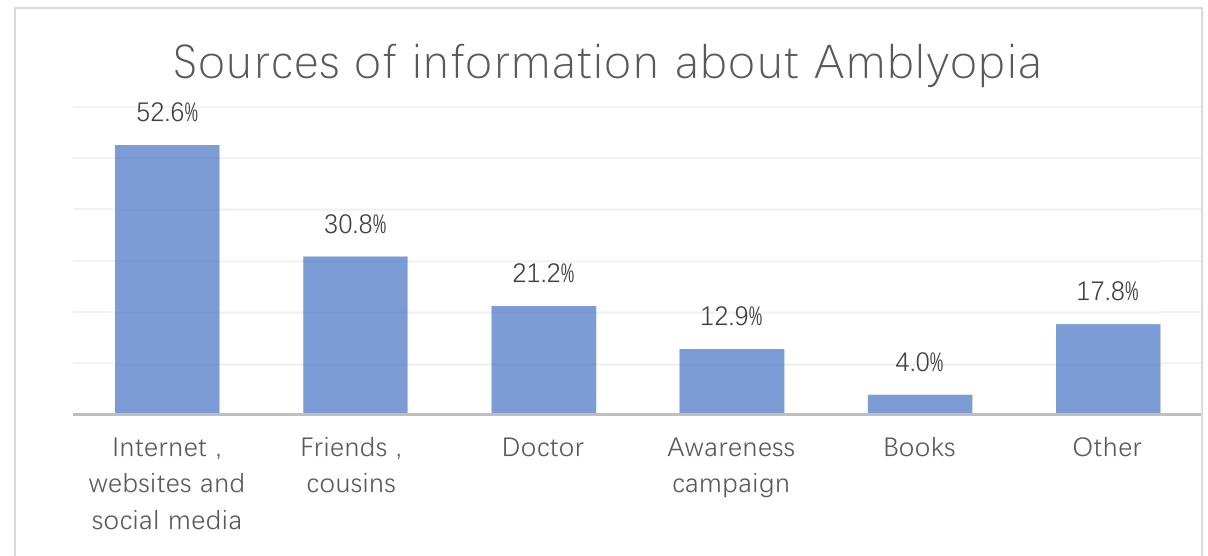
Figure 2. The proportions of participants’ responses for their knowledge regarding the causes of amblyopia, where they had the option to choose more than one answer. (The correct answers are represented by green bars and the incorrect answers by blue bars).